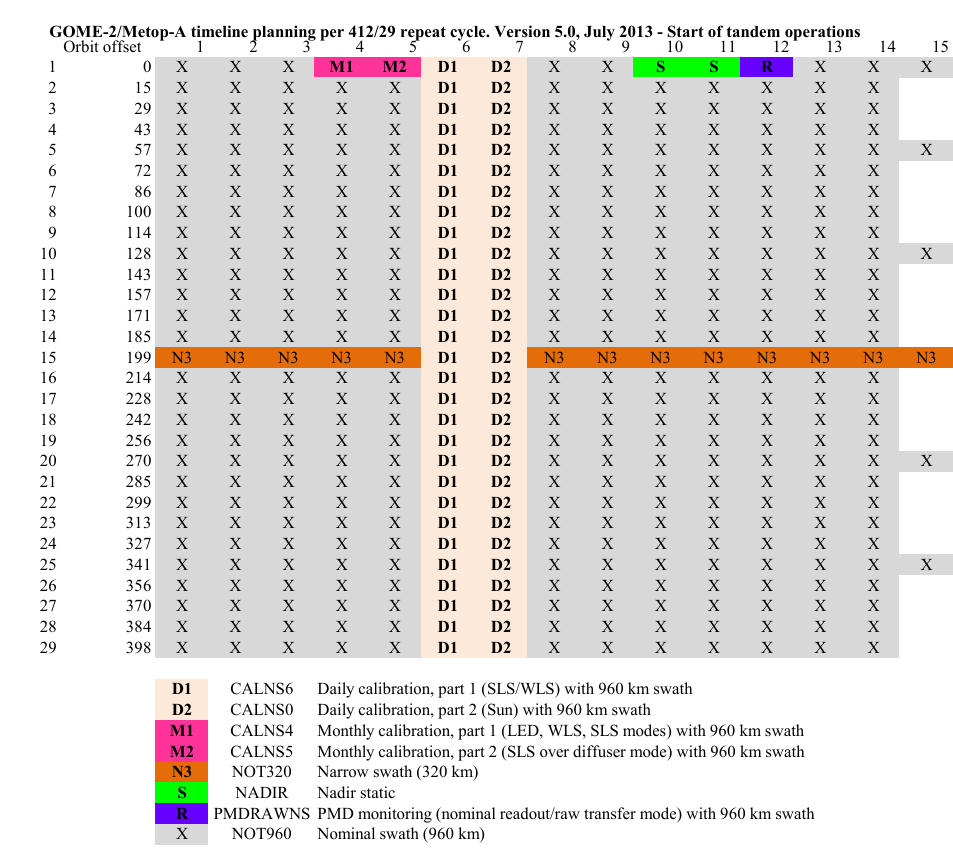
Figure 3. The 29-day instrument operation cycle for GOME-2 on Metop-A. Different colours and ID tags indicate different instrument operations settings as explained in the